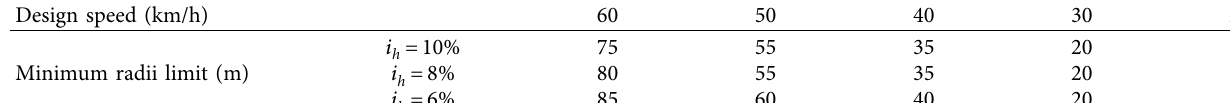
Table 6: Minimum radii limit for design superelevation and design